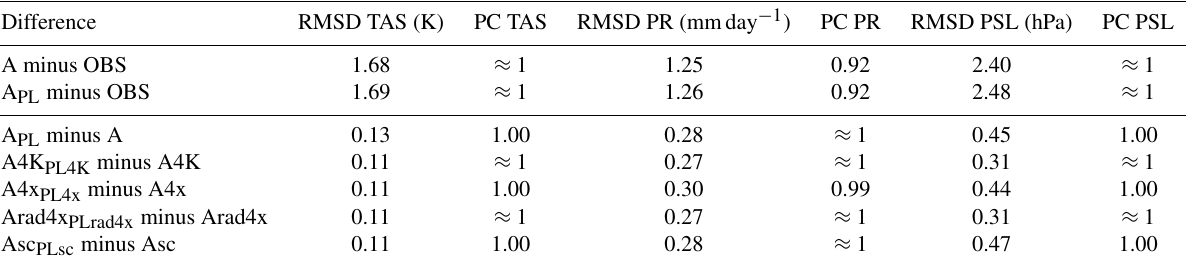
Table 2. The area-weighted RMSDs and pattern correlations (PCs) for surface air temperature (TAS), precipitation (PR) and mean sea level pressure (PSL) for the A and A PL simulations relative to the observational (OBS) reference datasets (rows 2 and 3). Rows 4–8: the RMSDs and PCs for each prescribed land simulation relative to its counterpart free land simulation (experiment names defined in Sect. 2). Difference RMSD TAS (K) PC TAS